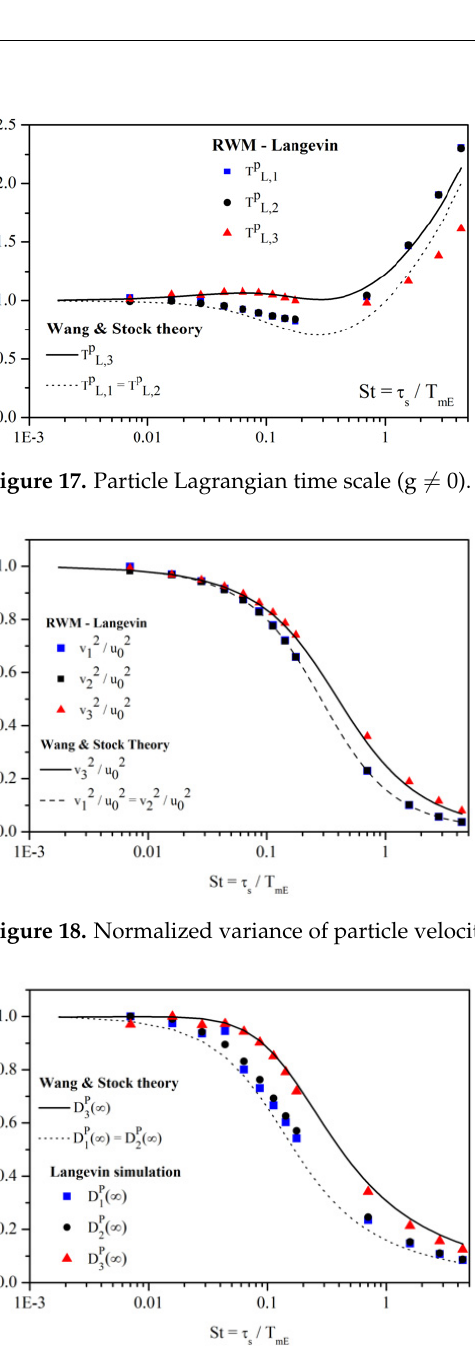
Figure 19. Particle dispersion coefficient (g ≠ 0).